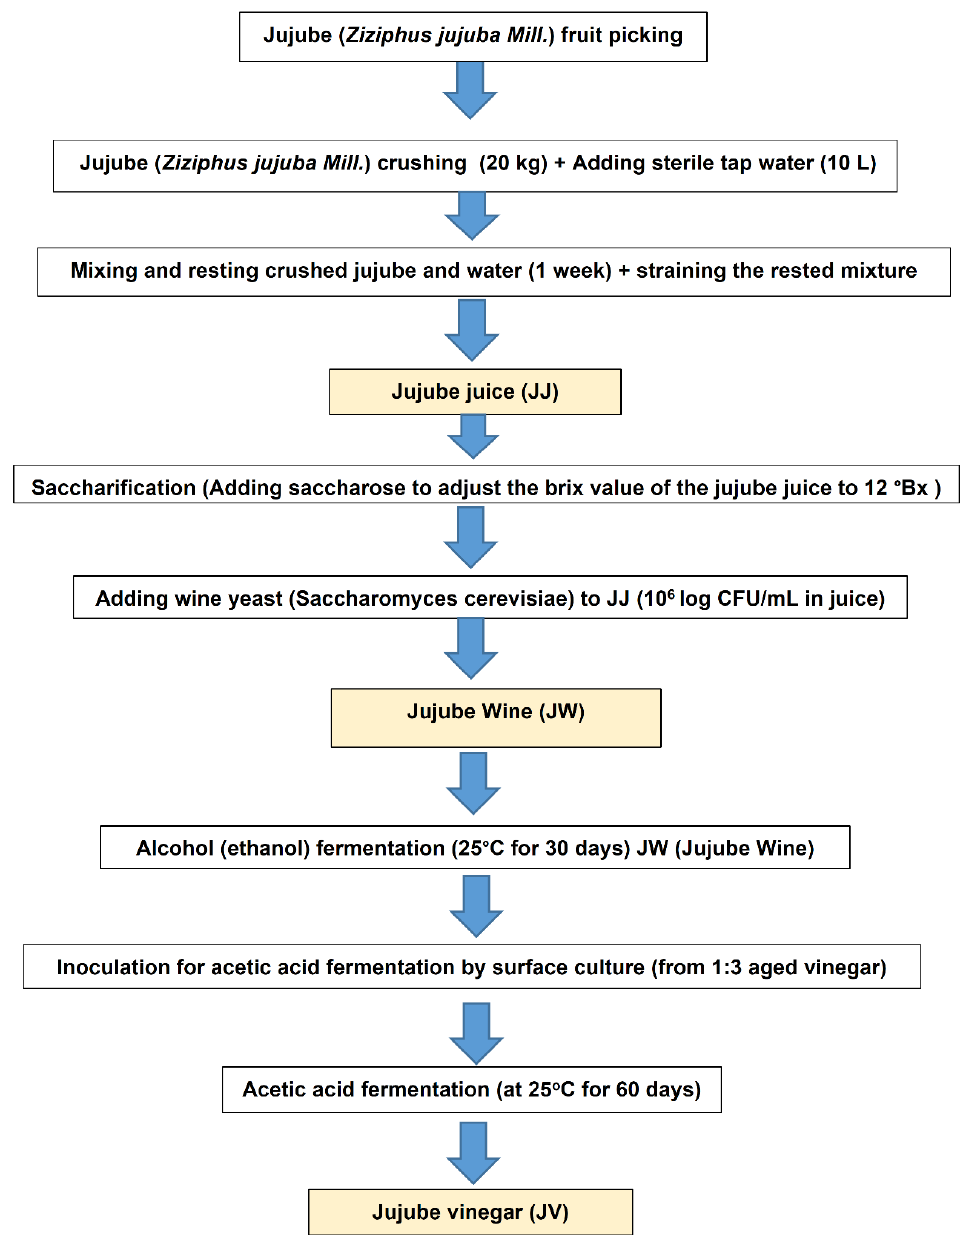
Figure 1. Jujube wine and vinegar production flow chart.